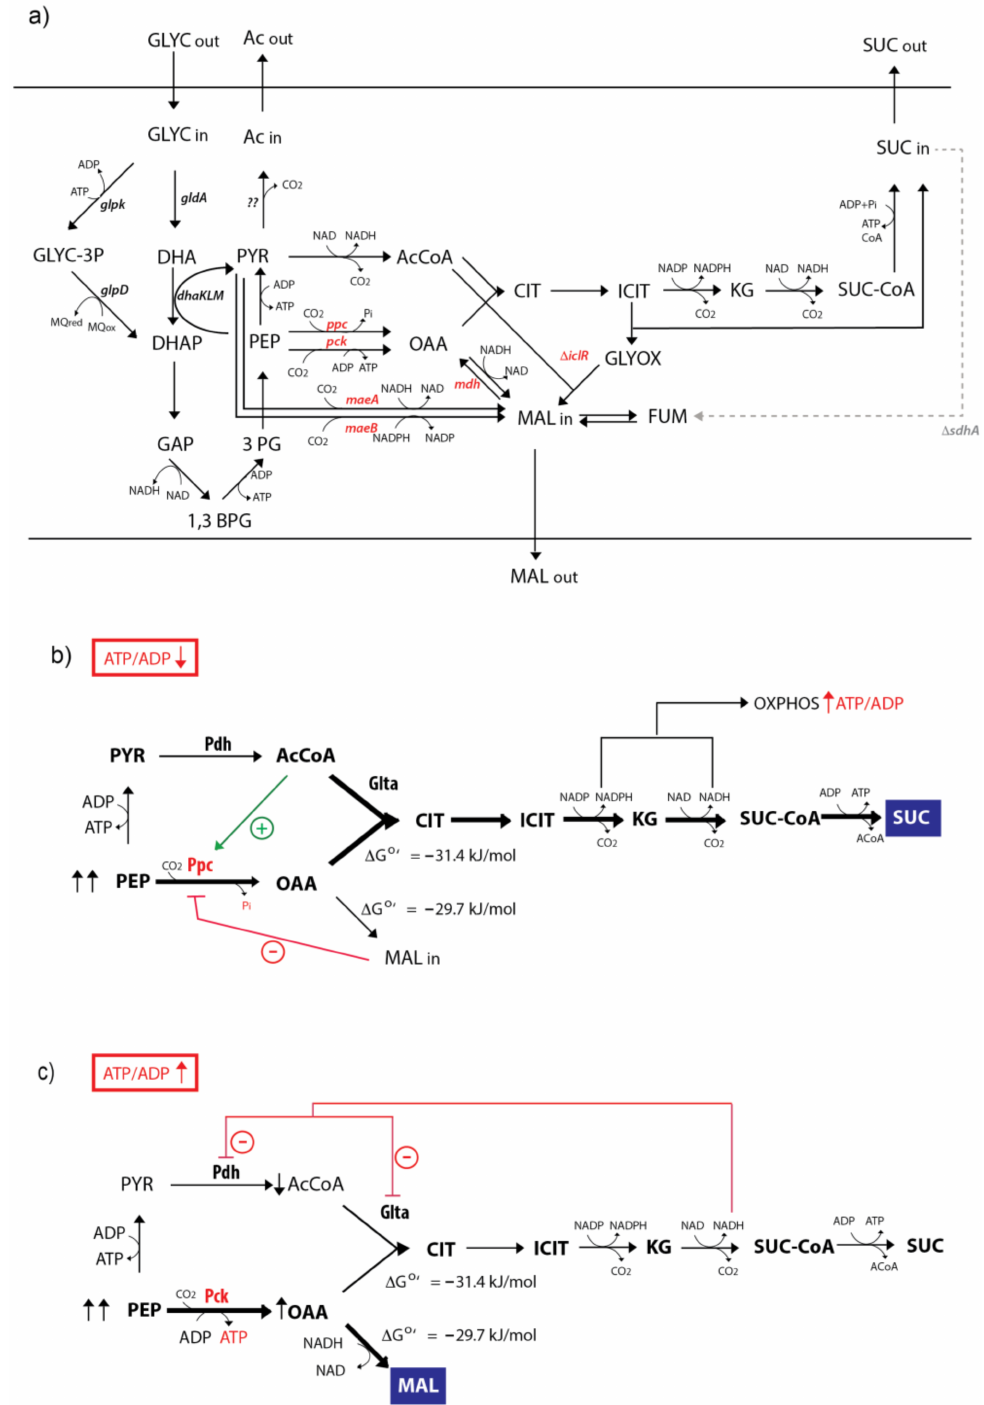
Figure 6. Metabolic diagram of glycerol assimilation and succinate and malate biosynthesis under a TCA cycle split into two branches due to the deletion of the succinate dehydrogenase ( sdhA ) gene (grey dashed line). Arrows in the PYR-PEP-OAA node indicate the net flux for each reaction in the M4- ∆ iclR strain when the enzyme marked in red is overexpressed. ( a ) Metabolic diagram with the genes overexpressed in this work depicted in red. The iclR gene is also highlighted in red to indicate activation of the glyoxylate shunt. ( b ) Metabolic rewiring proposed for overexpression of Ppc; ( c ) Metabolic rewiring proposed for overexpression of Pck. The acronyms are as follows: 3PG: 3-phosphoglycerate, Ac: acetate, AcCoA: Acetyl-CoA, CIT: citrate, DHA: dihydroxyacetone, DHAP: dihydroxyacetone phosphate, FUM: fumarate, Glta: citrate synthase, Glyc: glycerol, GLYOX: glyoxylate, ICIT: isocitrate, KG: 2- α -ketoglutarate, MAL: malate, OAA: oxaloacetate, OXPHOS: oxidative phosphorylation, PEP: phosphoenolpyruvate, Pdh: pyruvate dehydrogenase, PYR: pyruvate, SUC: succinate, SUC-CoA: